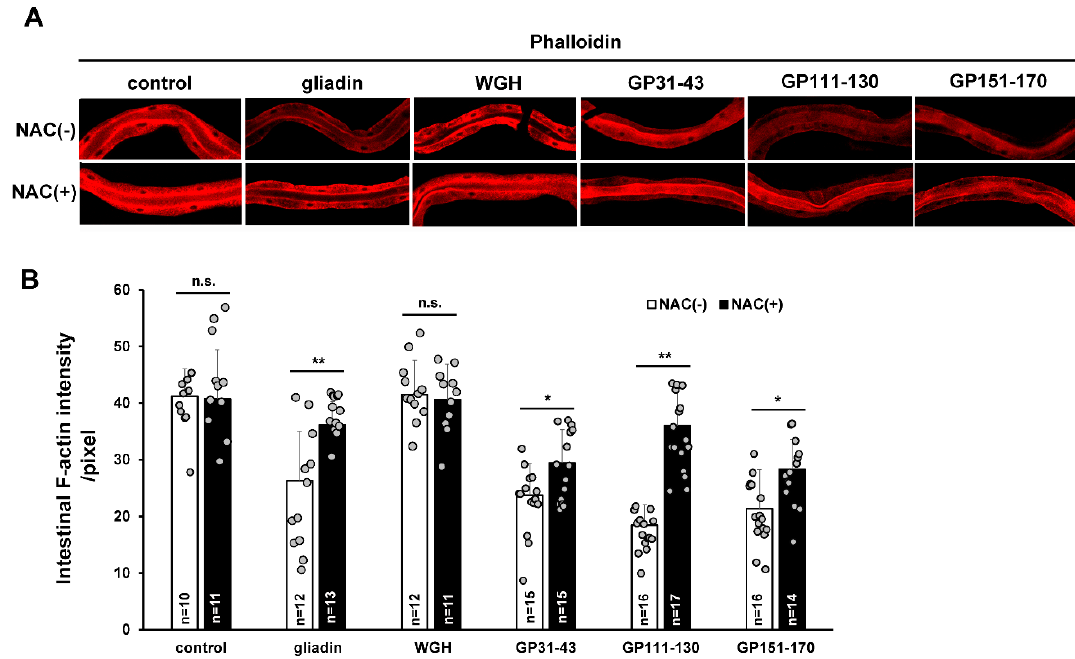
Figure 6. Effects of combining N-acetyl-L-cysteine (NAC) treatment with treatment by gliadin or synthetic gliadin peptides on intestinal F-actin in adult-stage wild-type N2 C. elegans . ( A,B ) Wild-type N2 worms synchronized at the L4 larval stage were treated with or without NAC and either no